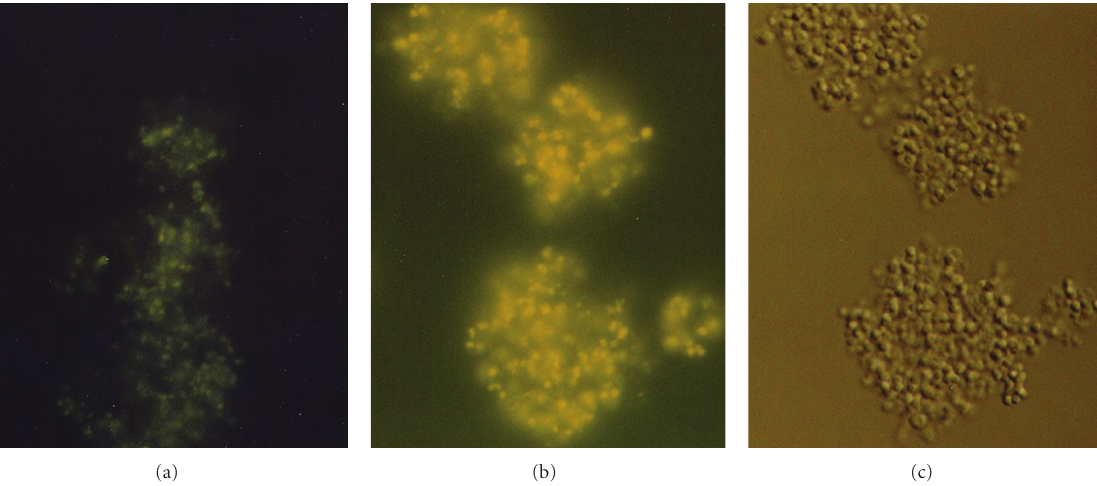
Figure 5: Immunoflluorescent images of M. Luteus . For (a) and (b), cells were observed under a fluorescent microscope with excitation wavelength 495nm and emission wavelength 520 nm. (a) a negative control in which M. luteus cells were incubated with the secondary antibody conjugated to FITC. (b) M. luteus cells were incubated with both anti-TUAS serum and the secondary antibody conjugated to FITC. (c) The same bacterial cells as (b) except under visible light. Table 1: TUAS activity found in fractions after partitioning with 25% ammonium sulfate. TUAS